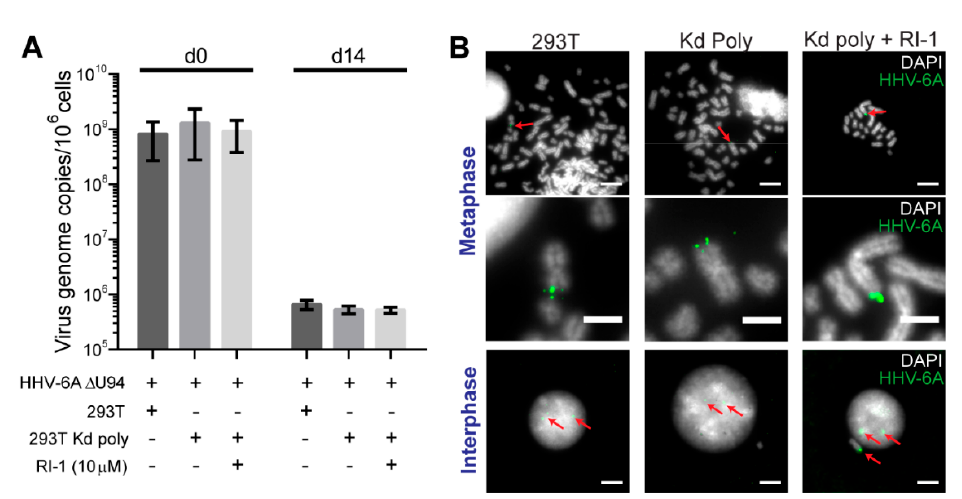
Figure 3. The effect of HHV-6A U41/U70 knockdown on HHV-6A integration. 293T or Kd polyclonal (Kd poly) cells were infected with the HHV-6A ∆ U94 virus and the GFP-positive cells sorted. Samples were taken immediately after sorting and 14 days later. ( A ) Mean virus DNA copies per million cells was quantified by qPCR using primers against viral U86 and cellular B2M. This number is displayed in the histogram ( n = 4 ± SEM). RI-1 is a specific inhibitor of the Rad51 cellular recombinase. ( B ) The 14-day samples were analyzed by FISH to detect the HHV-6A genome (green). Representative images are displayed for metaphase and interphase cells (DAPI staining shown in grey). Red arrows indicate the location of HHV-6A signals. Scale bars for the top and bottom images are 10 µm and 4 µm for the images in the middle.